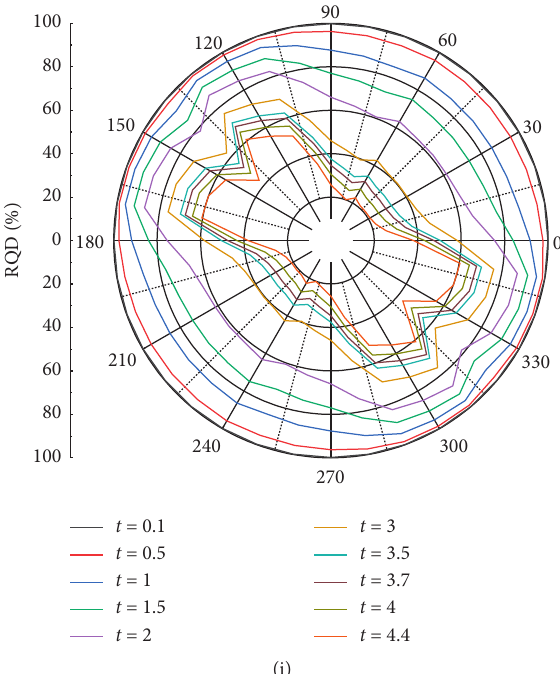
Figure 4: Generalized RQD with various thresholds in different directions of diverse models: (a) spacing 0.2, scalability:1–3; (b) spacing 0.2, scalability: 8–14; (c) spacing 0.2, scalability: 20–30; (d) spacing 1, scalability: 1–3; (e) spacing 1, scalability: 8–14; (f) spacing 1, scalability: